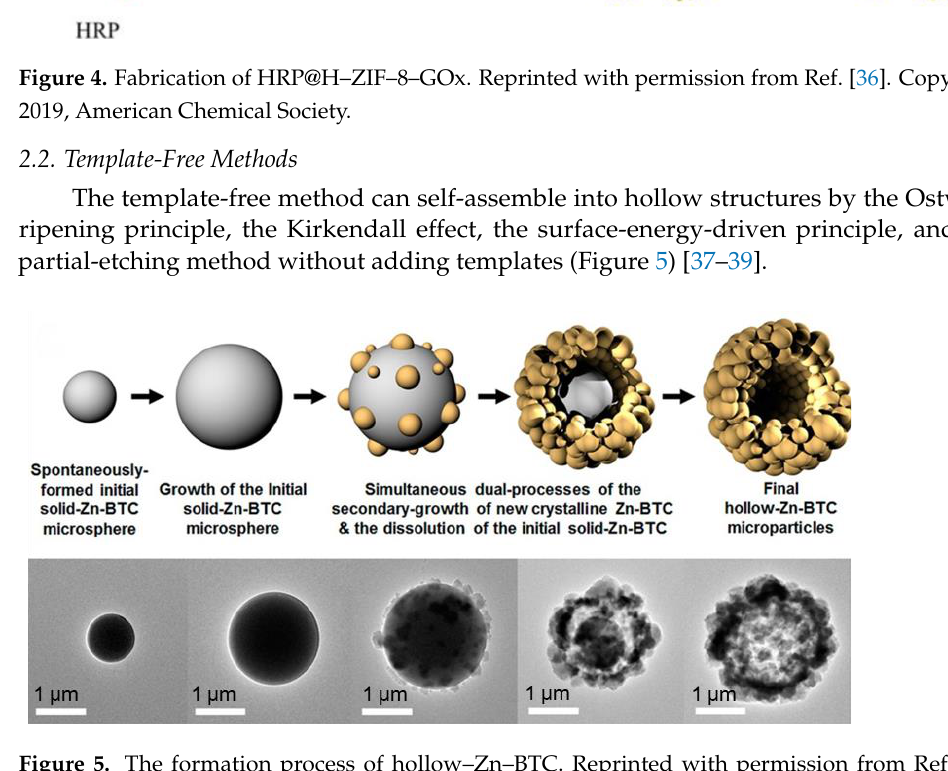
Figure 5. The formation process of hollow – Zn – BTC. Reprinted with permission from Ref. [37]. Copyright 2015, American Chemical Society.